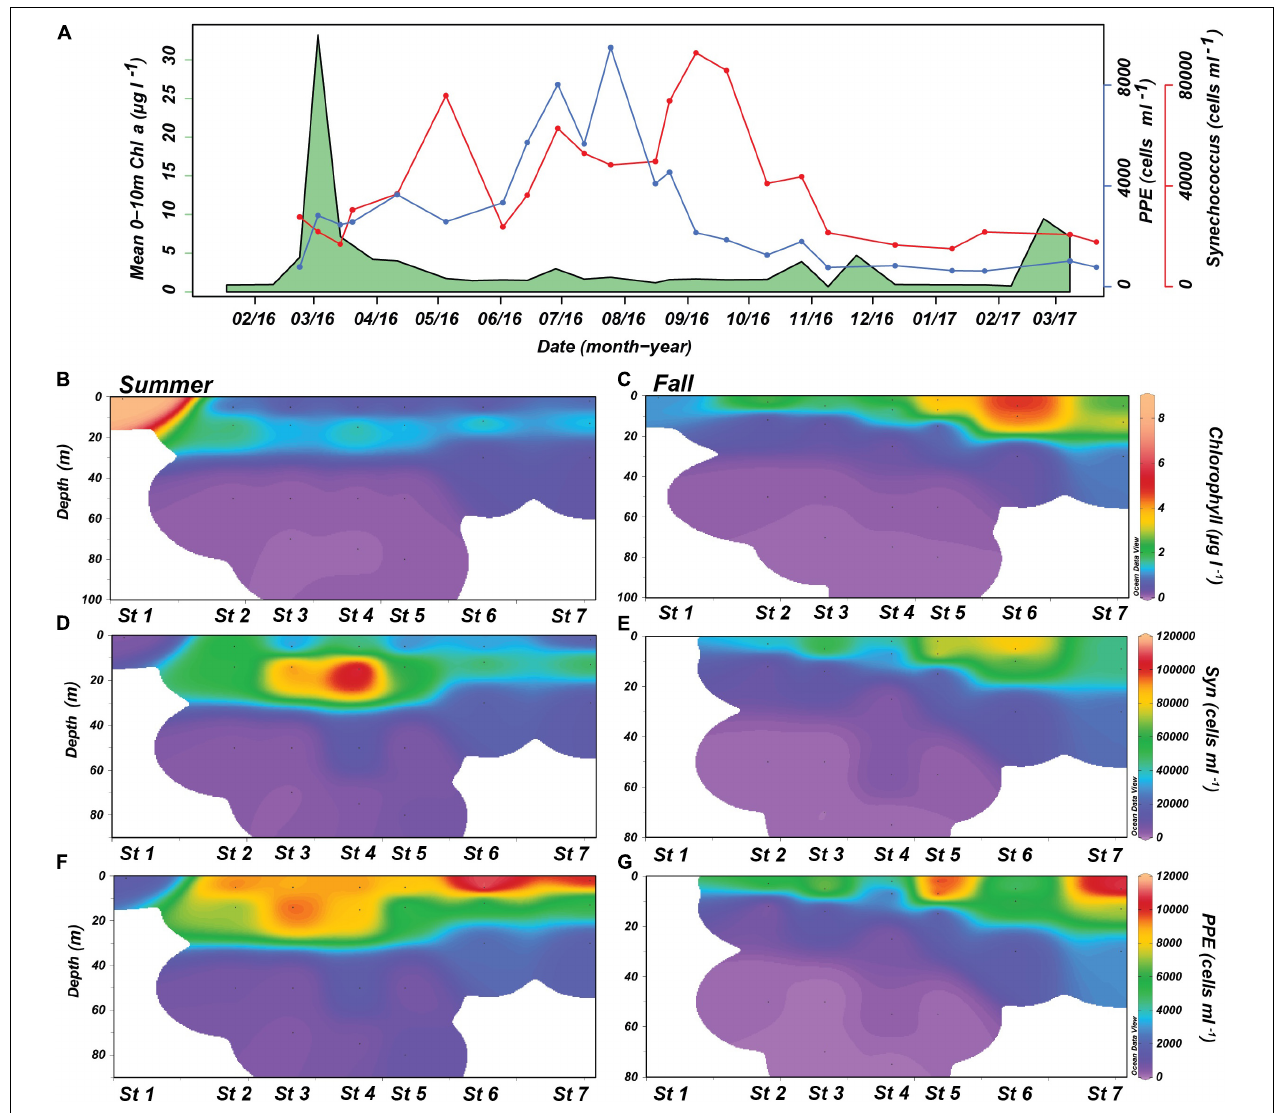
FIGURE 3 | Picophytoplankton and chlorophyll a (Chl a ) concentrations during the time series, summer, and fall transects. (A) Mean Chl a concentrations from 0 to 10 m, photosynthetic picoeukaryote (PPE) and Synechococcus cell abundances over the 2016–2017 time series. (B,C) Chl a concentrations, (D,E) Synechococcus cell abundances, and (F,G) PPE cell abundances from the KB1707 and KB1709